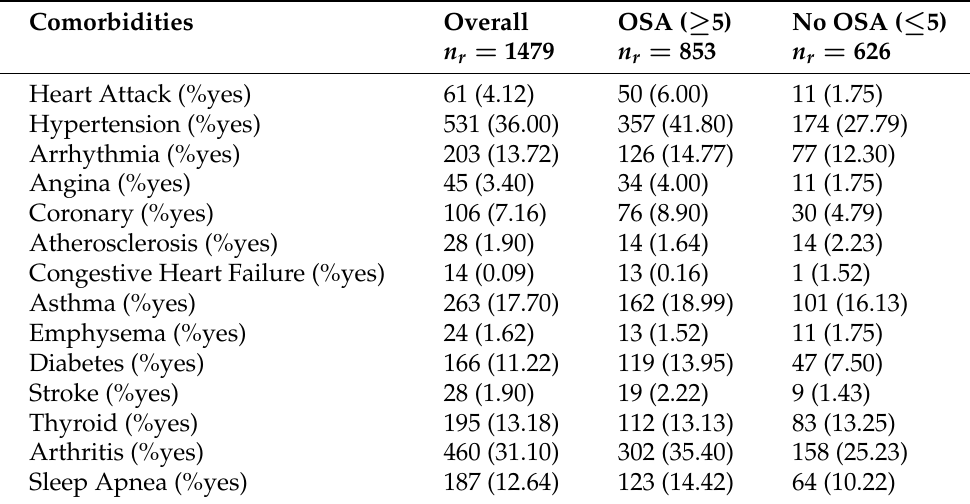
Table A6. Comorbidities characteristics of cohort expressed as mean ± standard